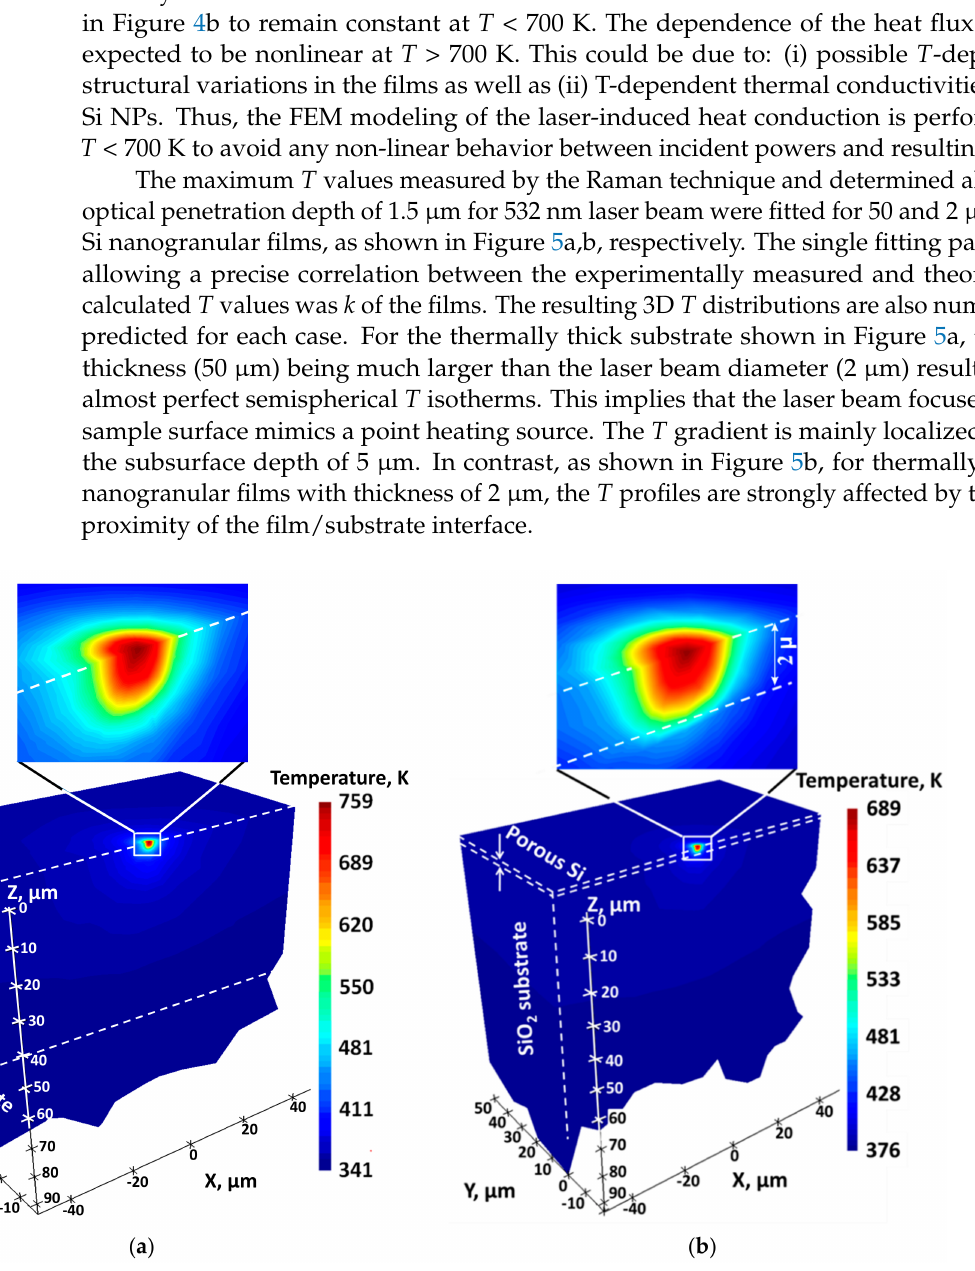
Figure 5. In-depth T distribution for porous Si NP films deposited on 1 mm thick SiO 2 glass substrate with the film thickness of ( a ) 50 µ m and ( b ) 2 µ m. Film heating is induced by a 532 nm wavelength laser beam of 2 µ m diameter focused on the film